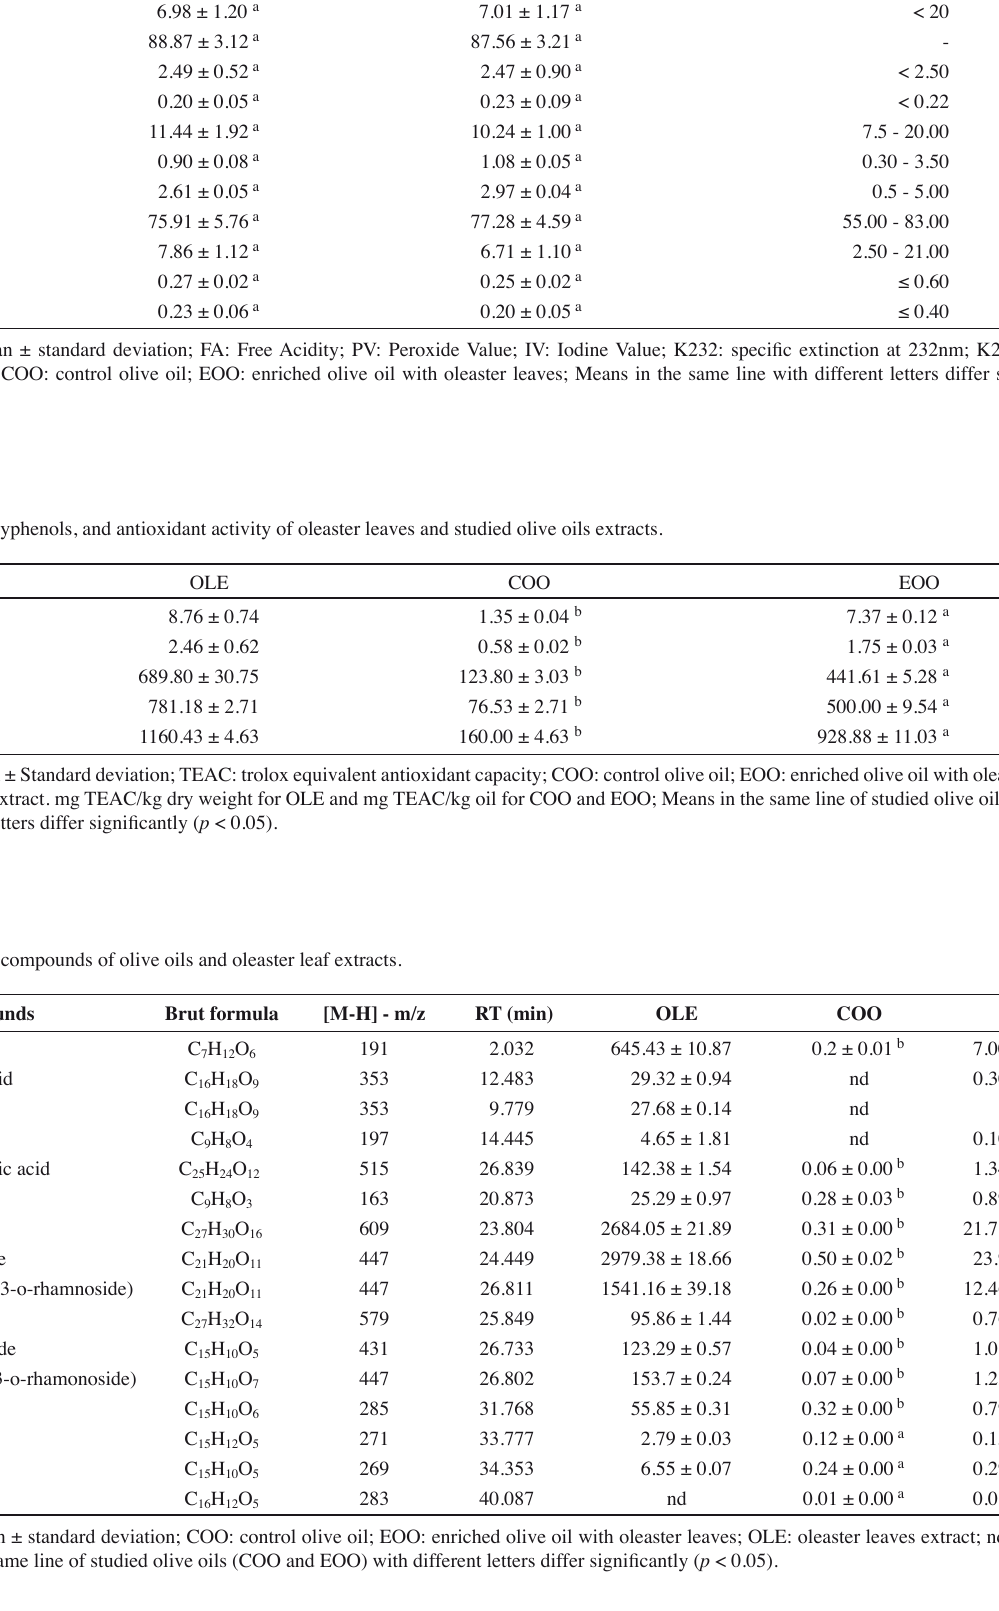
Norma of extra virgin olive oil (IOC, 2019)